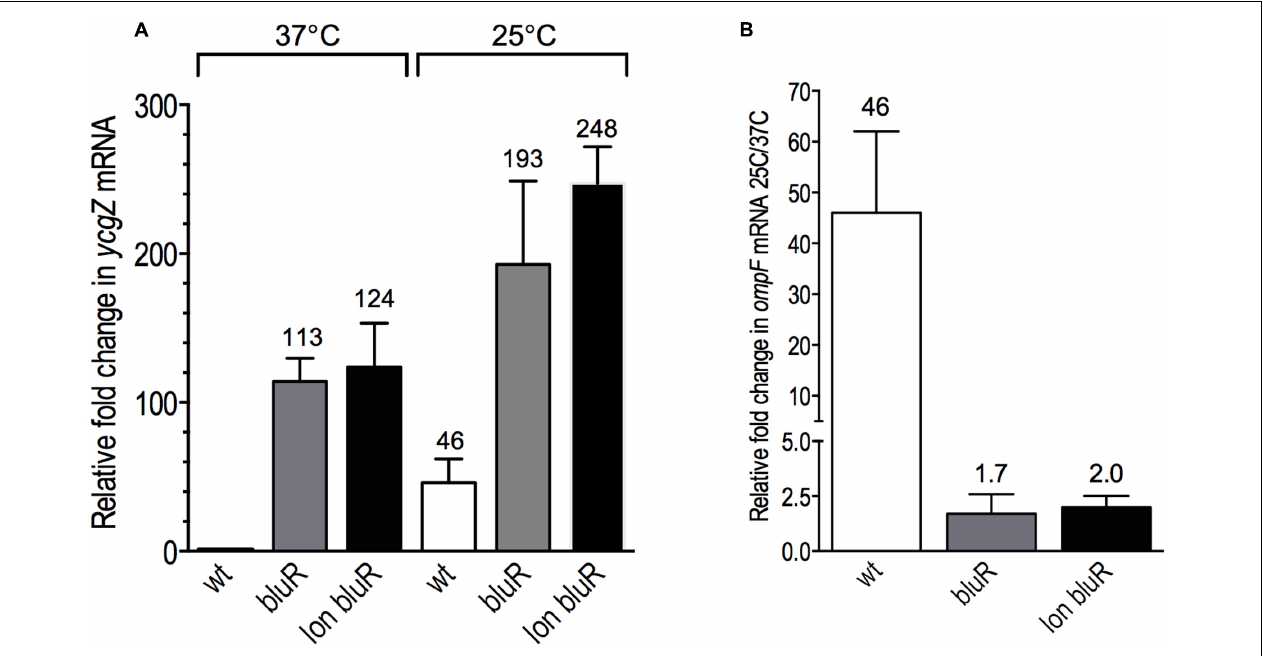
FIGURE 4 | BluR is controlling the temperature-dependent expression of ycgZ . (A) Fold change in YcgZ mRNA levels relative to the wild type strain AG100 grown at 37 ◦ C. (B) Fold change in YcgZ mRNA levels for all strains grown at 25 versus 37 ◦ C. The cells were grown to exponential phase (optical density at 600 nm ∼ 0.6) in LB medium. Total RNAs were prepared and used to measure the YcgZ mRNA levels by RT-qPCR. Numbers represent the means and standard deviations of expression levels from three independent experiments performed in duplicate. AG100, wt; AGEZ3, bluR ; M113REZ3, lon bluR . See Supplementary Tables S4, S5 for